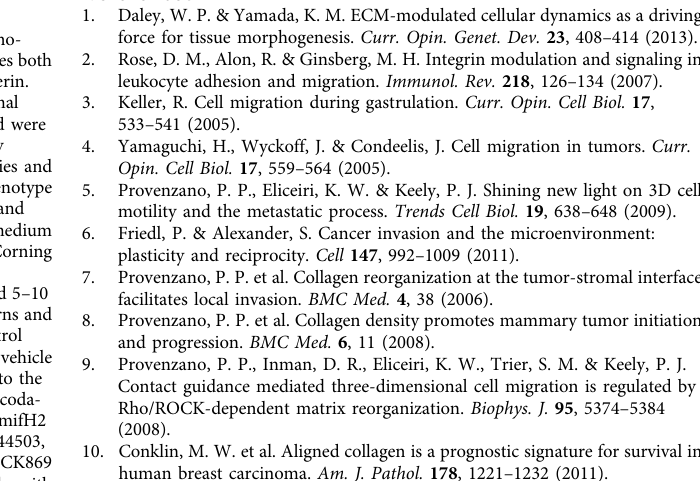
reported in the corresponding plots. Data are shown as mean±